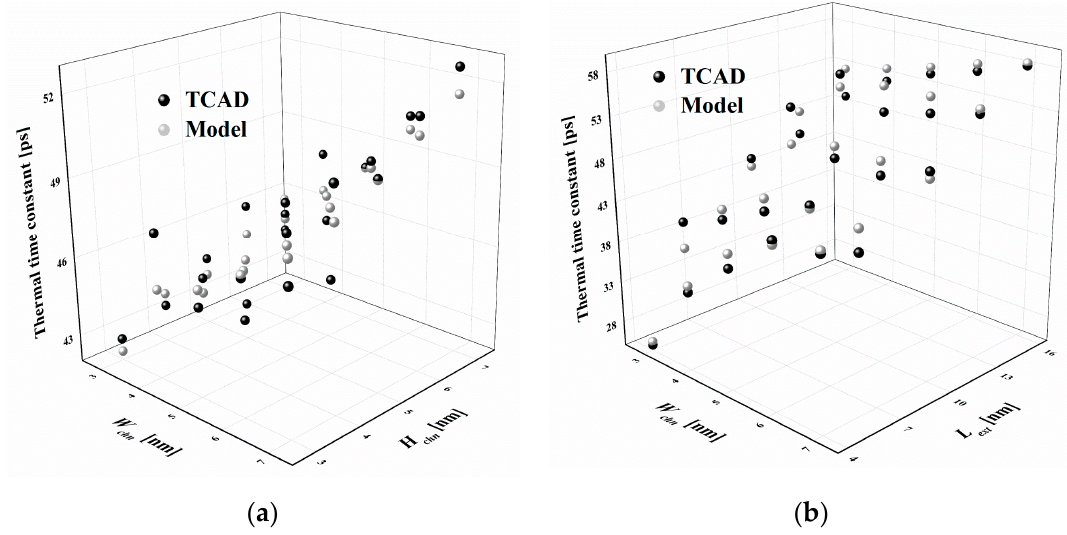
Figure 8. Scatter plot of thermal time constant, along with variation of ( a ) W chn and H chn , ( b ) W chn and L ext.